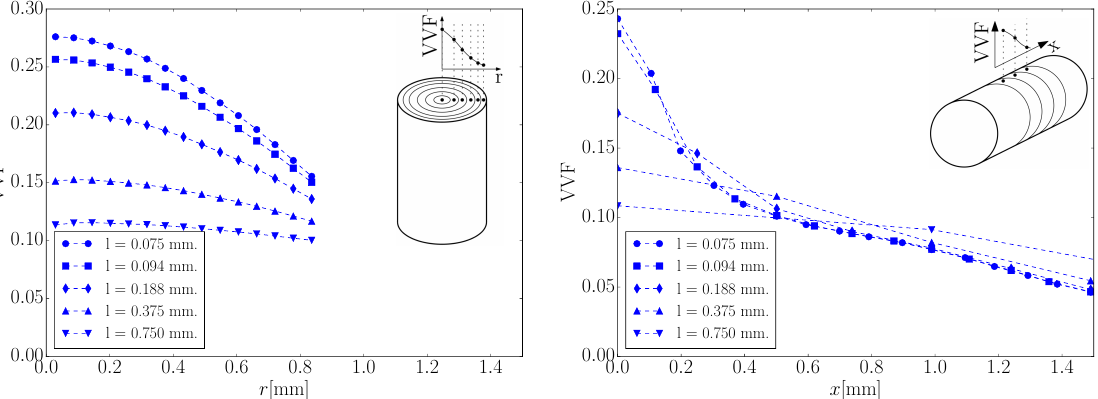
Figure 19. Radial ( left ) and longitudinal ( right ) voids distribution of a specimen of Material 2 at step 5 obtained using meshes with different element longitudinal